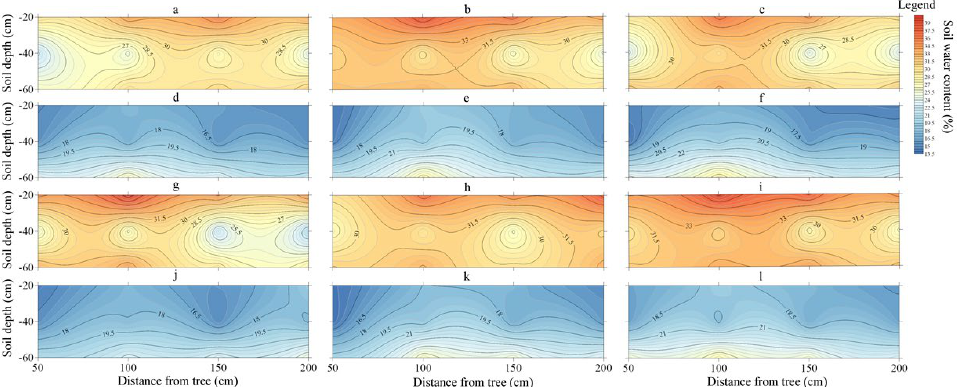
Figure 4. Two−dimensional soil total s alt content distribution in different stages of monocropping apple and ryegrass apple intercropping system (( a , d , g , j ): flowering and fruiting period; ( b , e , h , k ): fruit enlarging period; ( c , f , i , l ): fruit maturing period; monocropping apple (first and third rows) and ryegrass apple intercropping system (second and fourth rows); in the 2020 (top two rows) and 2021 (bottom two rows) seasons).